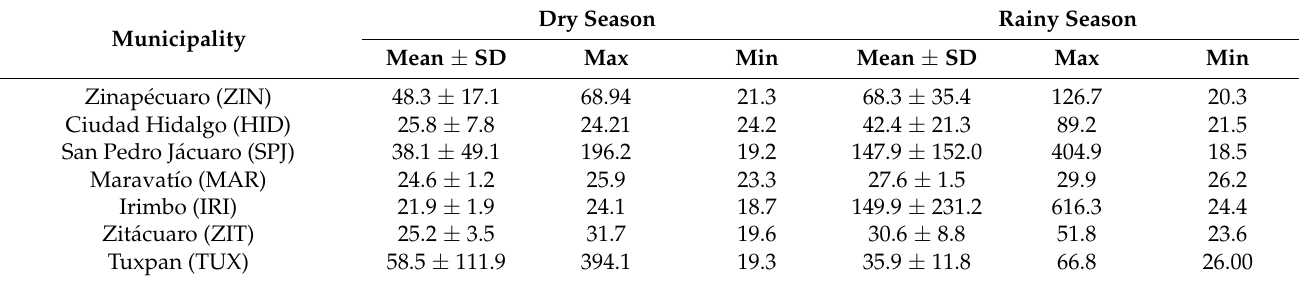
Table 4. Mean WQI values for municipalities from the eastern Michoac á n region. Dry Municipality